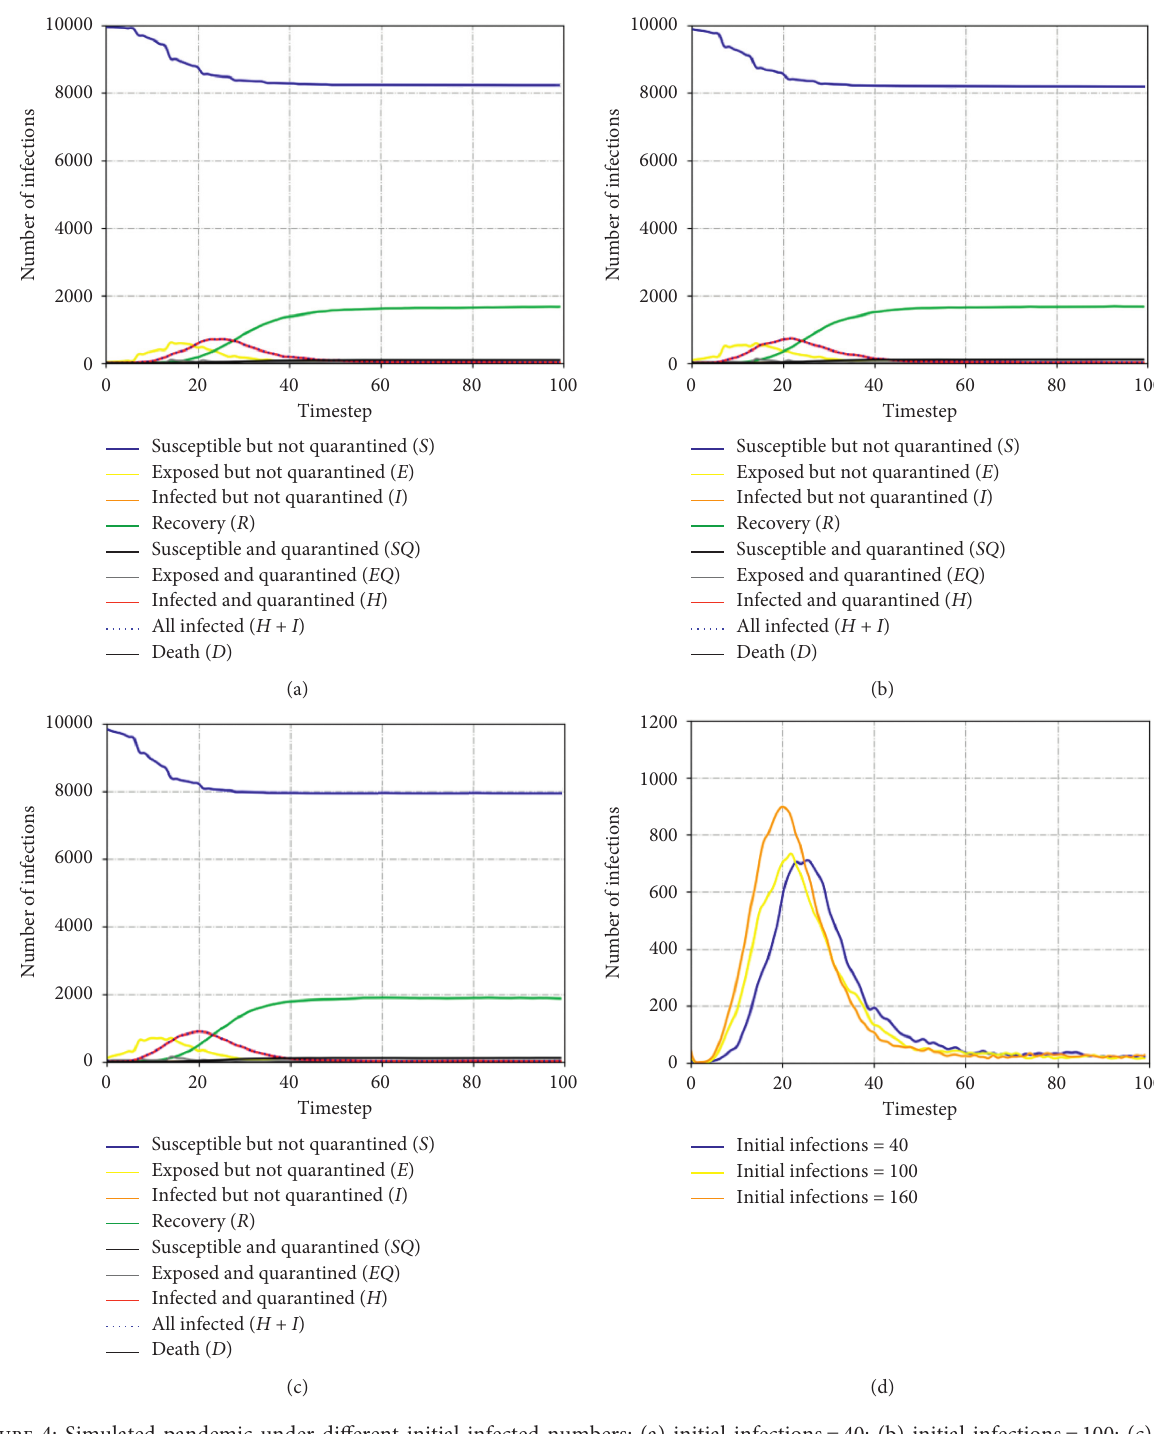
Figure 4: Simulated pandemic under different initial infected numbers: (a) initial infections � 40; (b) initial infections � 100; (c) initial infections � 160; (d) initial infections comparison